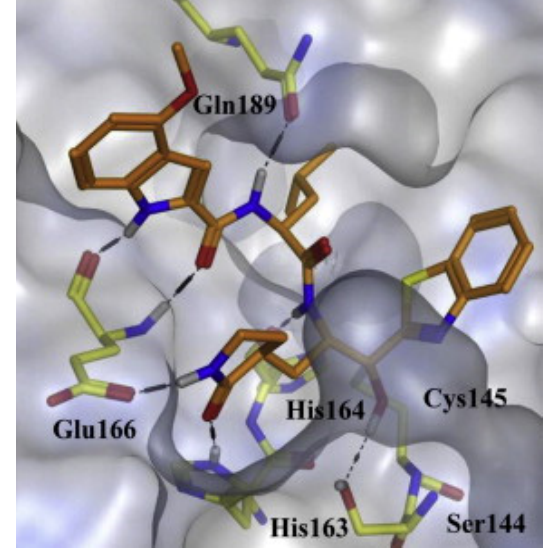
Figure 2. Molecular docking poses and binding interaction of 17 bound to SARS-CoV 3CL pro